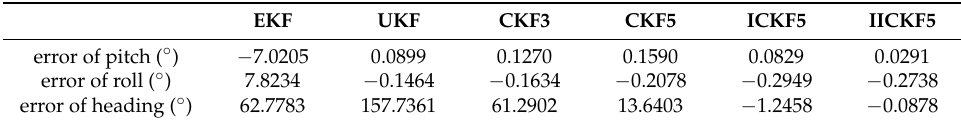
Table 1. Comparison of alignment errors (°).